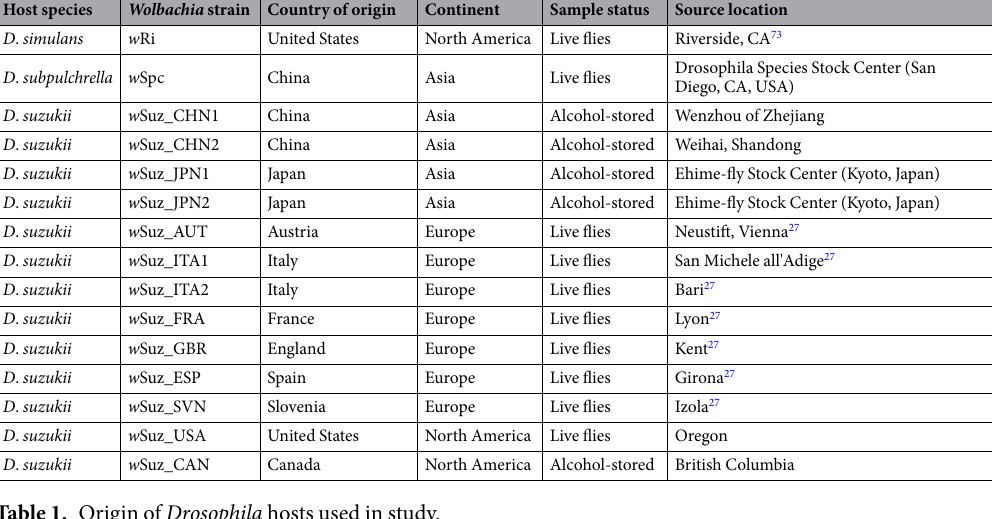
Table 1. Origin of Drosophila hosts used in